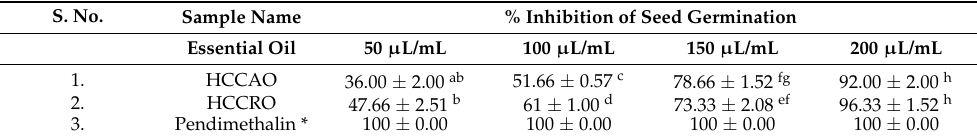
Table 8. Mean percent seed germination inhibition of HCCAO and